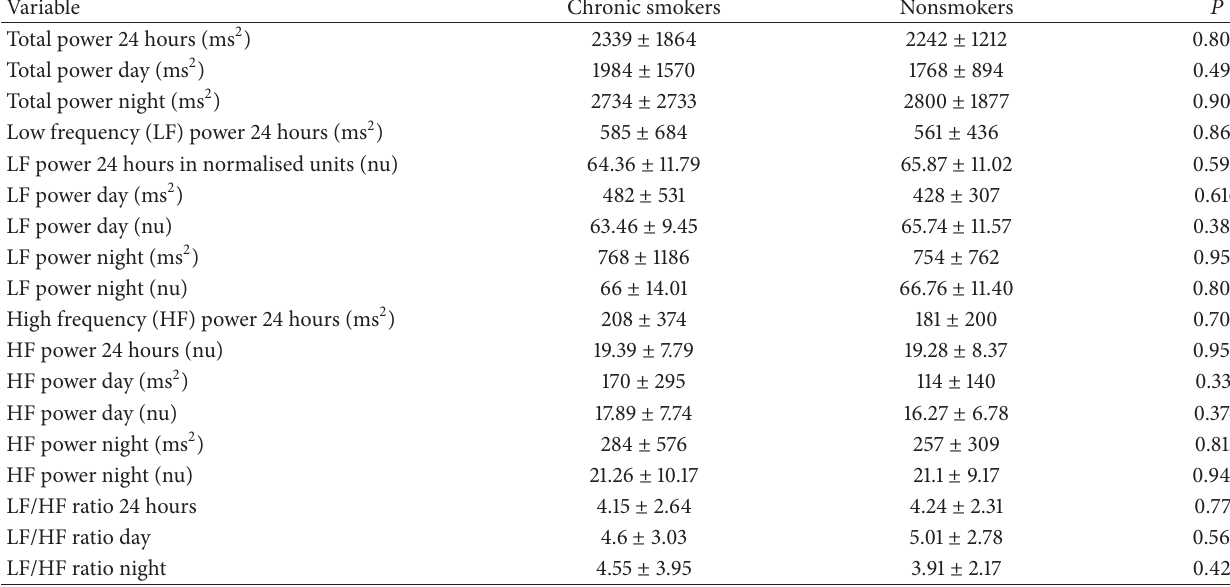
Table 2: Mean values ( ± SD) of frequency-domain parameters of HRV during 24-hour, day, and night periods.